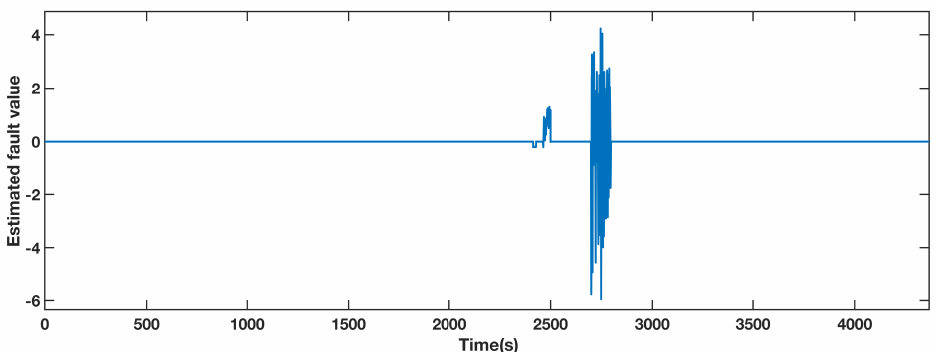
Figure 5. Estimated fault value from adaptive observer designed for the pitch angle 2.